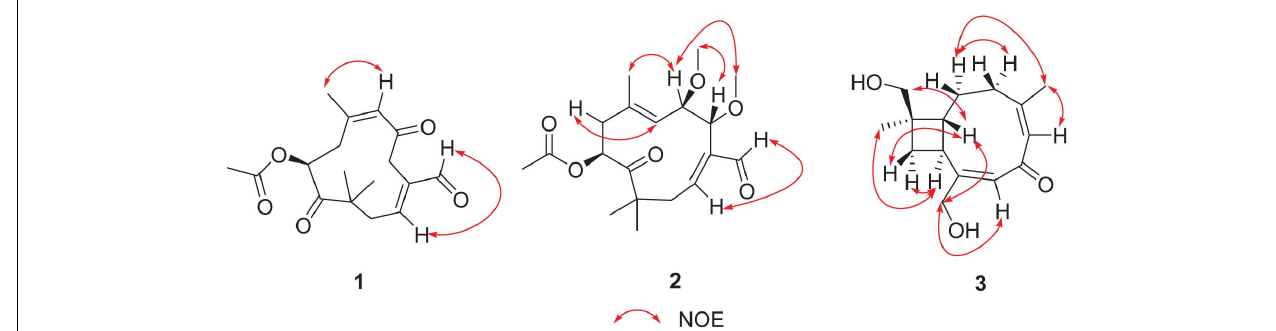
FIGURE 3 | Selected NOESY correlations for compounds 1–3 .